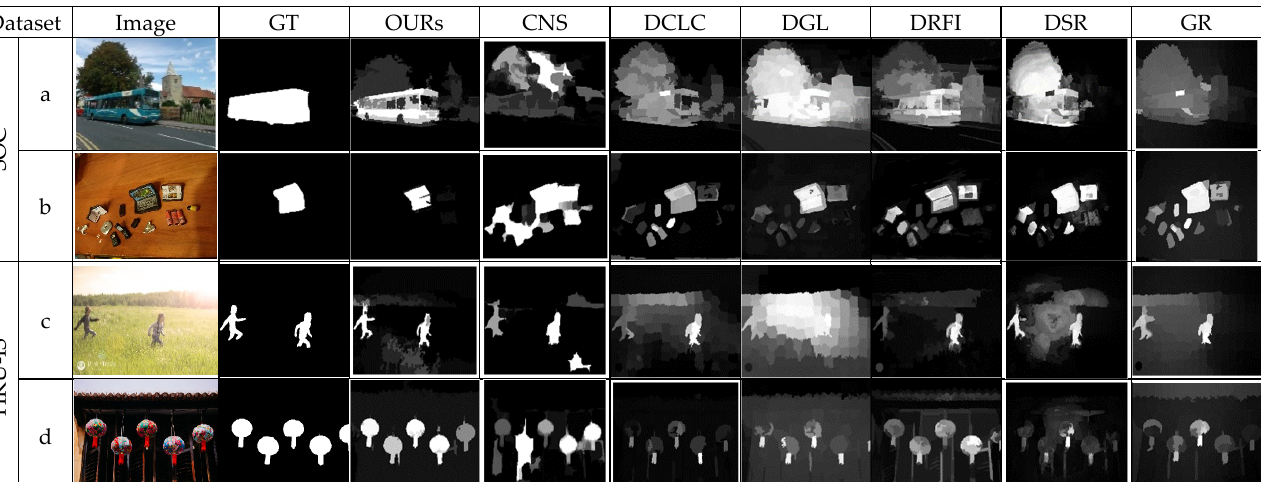
Table 2. The performance statistics for six categories of images. The up arrow  indicates that a higher value gives better performance, and the down arrow  shows that a lower value gives better performance.